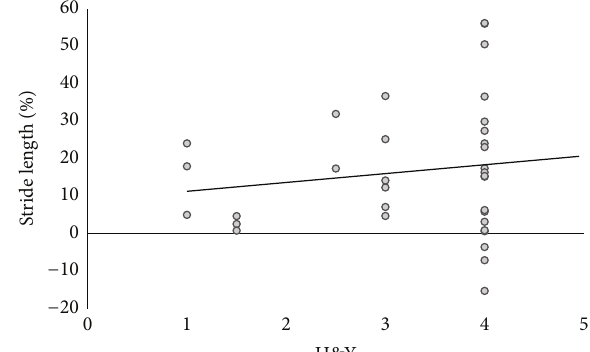
Figure 3: Correlation observed between the PD clinical status (H&Y) and the stride length percentage of improvement (stride length %) after